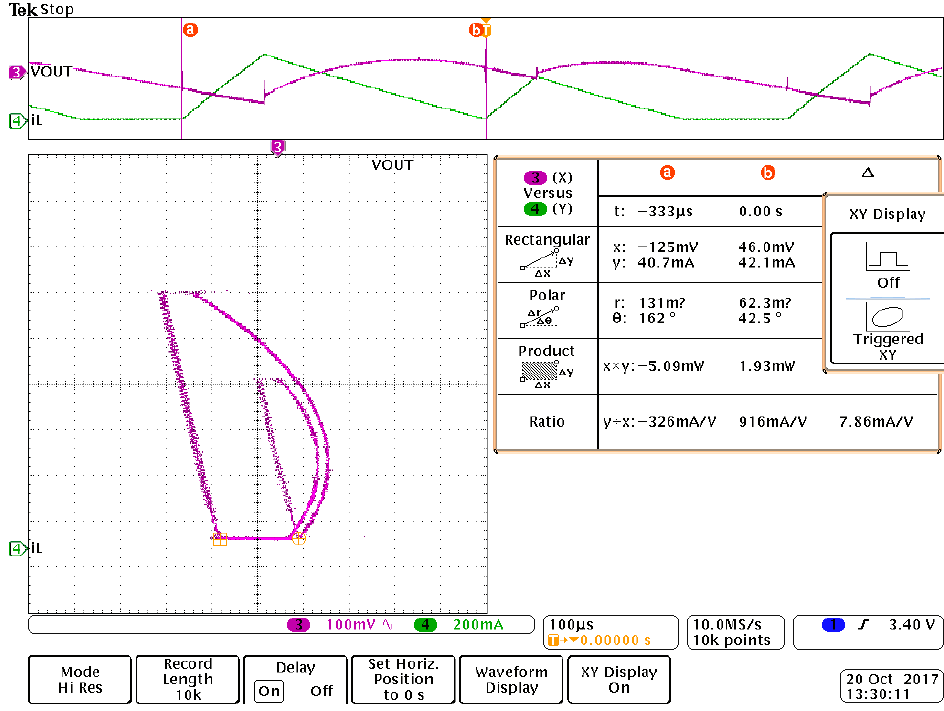
Figure 14. Phase portrait for k = 1.20, clearly revealing period 2 operation.